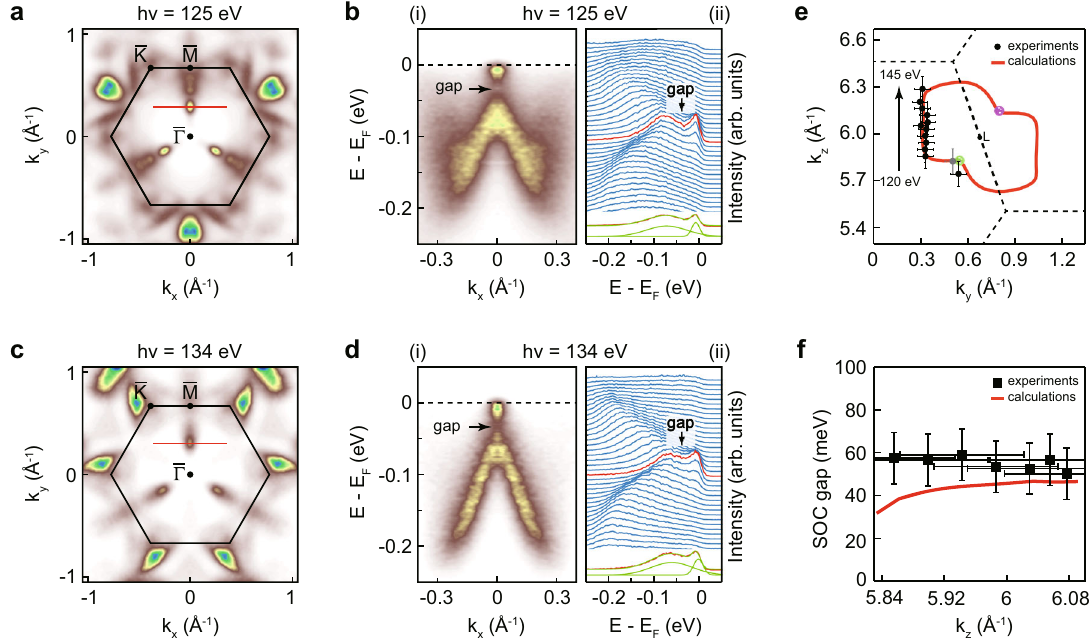
Fig. 4 SOC-induced gap size along the nodal line. a The Fermi surface topology taken at 125 eV photon energy. Three spot-like features are observed along Γ M direction which originate from the upper branch of the gapped nodal line. b The extracted band structure (i) and its corresponding EDCs (ii) perpendicular to the Γ M direction through the spot-like feature. The momentum path is illustrated by the red line in ( a ). The SOC-induced gap is clearly observed as illustrated by the arrow. To quantitatively extract the gap size, the EDC in red is fi tted by using two Lorentzian curves as illustrated by the green curves in the inset of (ii). c , d The same to ( a , b ) but the data are taken at 134 eV photon energy. Note that the experimental plot has been symmetrized according to the crystal symmetry. e The extracted positions of nodal line. The gray point is taken by 115 eV photon energy and the position is obtained based on the inversion symmetrization. The experimental results show excellent agreement with the calculations. f The comparison of the SOC gap between the experiments and calculations shows overall